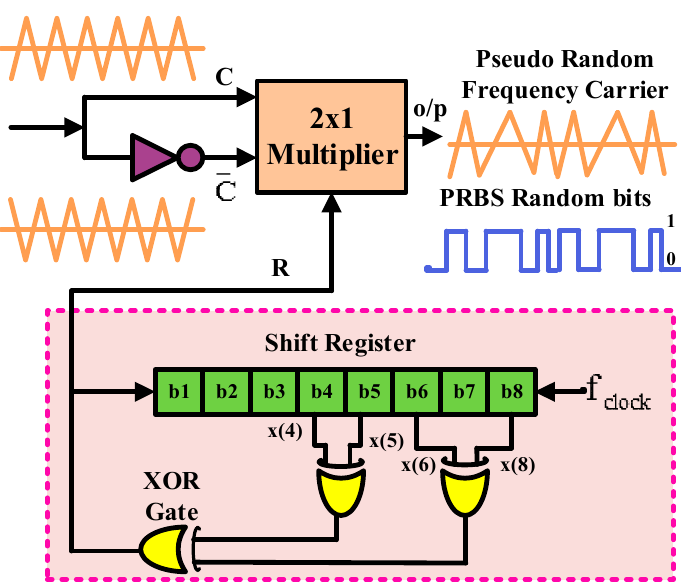
Figure 2. Conventional pseudorandom binary sequence RPWM.